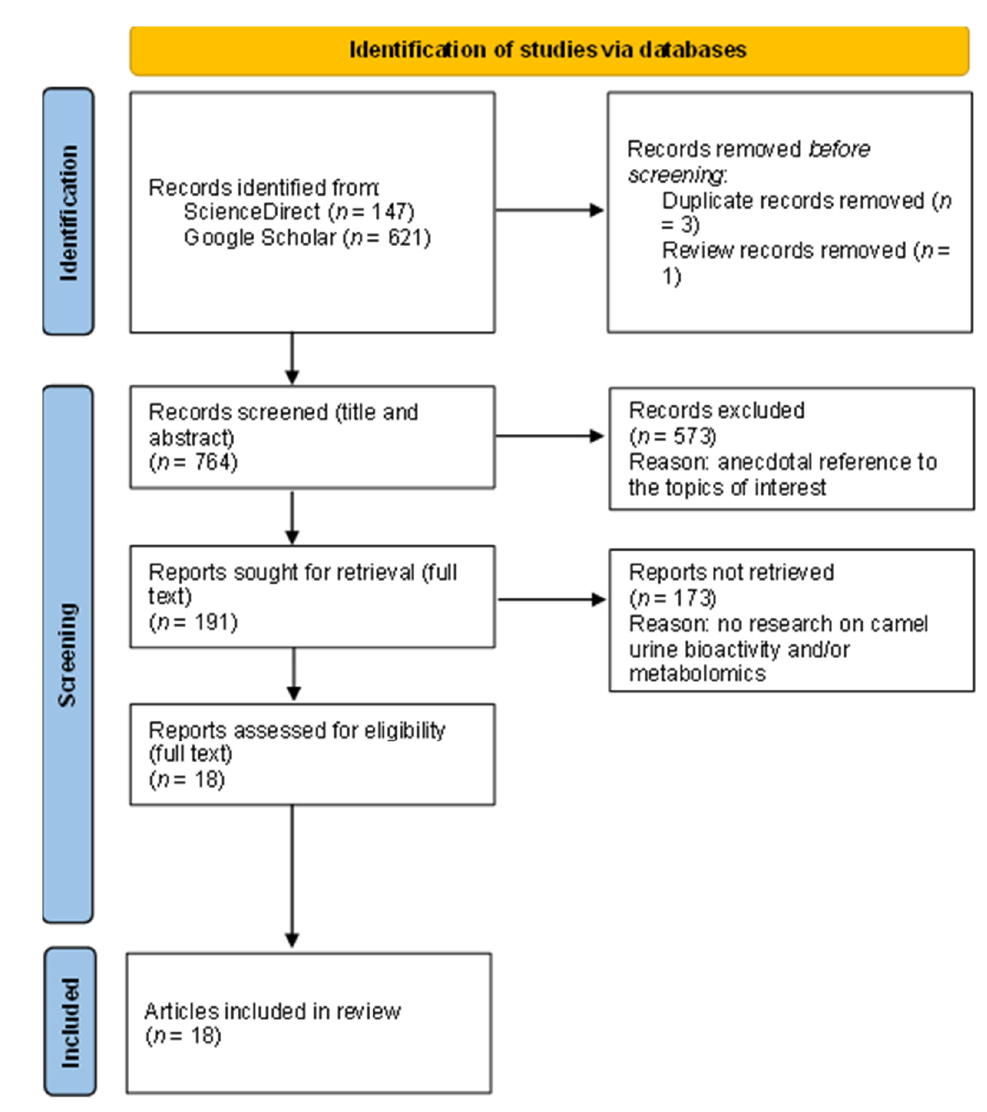
Figure 1. Process flow chart showing the sequential steps of literature search and review in the present study.